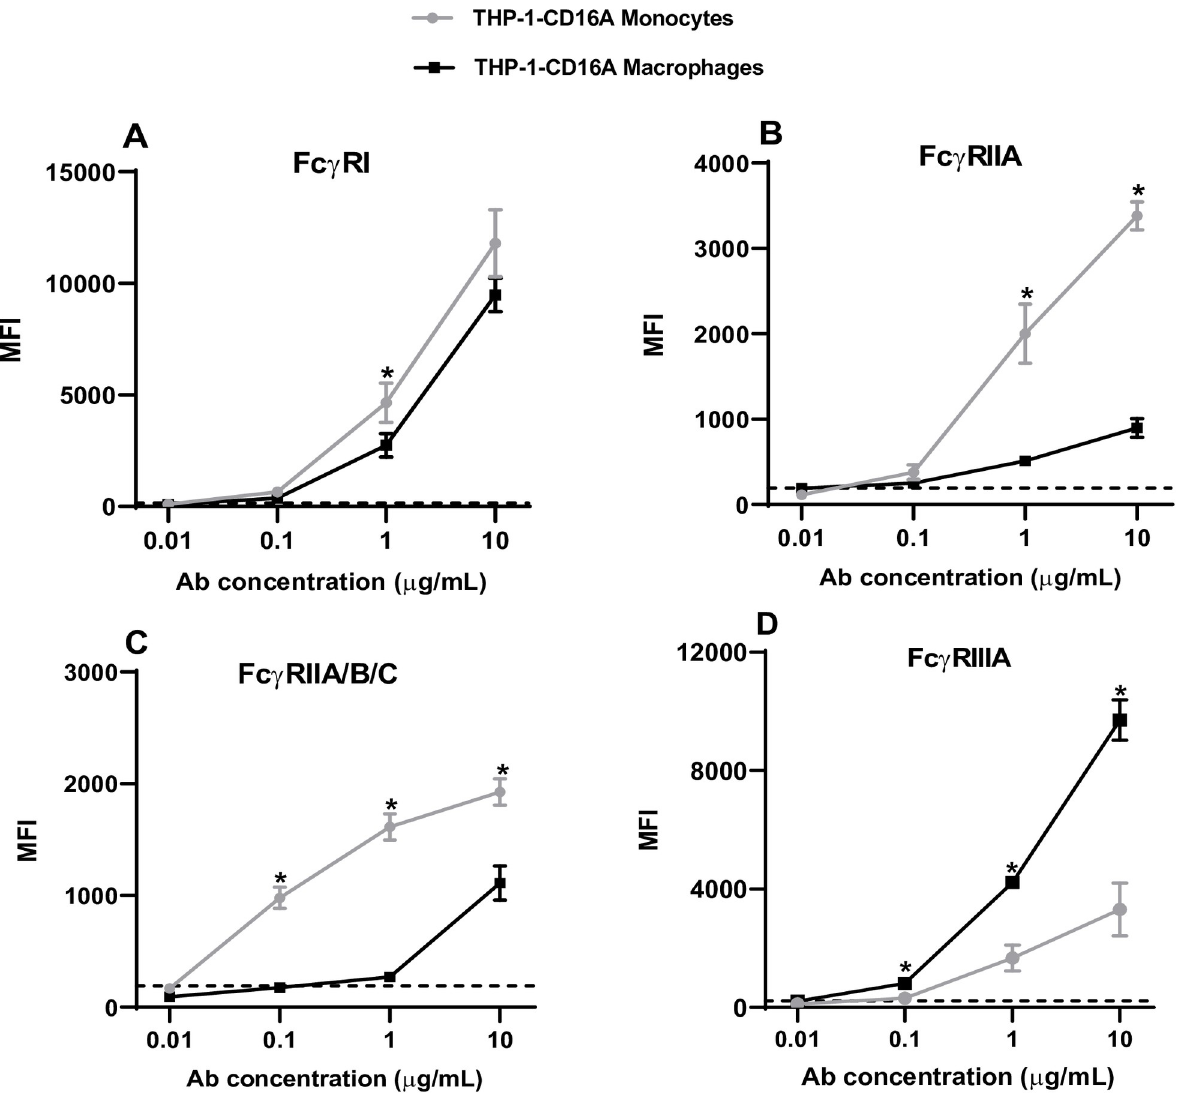
Fig 3. Expression of human Fc γ Rs on non-differentiated and PMA-differentiated THP-1-CD16A cells. THP-1-CD16A cells were differentiated to macrophages by treatment with PMA (100 ng/mL) as described in the Materials and methods. Five hundred thousand cells were stained with direct-labelled monoclonal antibodies against (A) Fc γ RI (clone 10.1 conjugated to PE/Cy7), (B) Fc γ RIIA (clone IV.3 conjugated to FITC), (C) Fc γ RIIA/B/C (clone AT10 conjugated to AF647), or (D) Fc γ RIIIA (clone 3G8 conjugated to BV421). Stained cells were washed and analyzed by flow cytometry using a BD LSRFortessa X-20. Data analysis was performed using FlowJo v10. Data are presented as the mean ± the standard deviation from four independent experiments. MFI: Mean fluorescent intensity (arbitrary units). Ab concentration: Concentration of the fluorescent antibody for Fc γ R expression detection. The dashed line represents the MFI value of the corresponding isotype control at 10 μ g/mL. The statistical analysis was performed by the non-parametric Mann-Whitney T-test, comparing the MFI of both conditions for each antibody concentration ( � : p = 0.05). without any blocking antibody (Fig 5A). However, in THP-1-CD16A cells, roughly 30% of phagocytosis was reduced when they were incubated with a Fc γ RIIIA blocking antibody (Fig 5B), demonstrating the contribution of Fc γ RIIIA in the phagocytosis of anti-D-opsonized human erythrocytes in these cells. Moreover, a very low level of phagocytosis was attained when THP-1-CD16A cells were treated with a combination of all blocking antibodies (Fig 5B), demonstrating that multiple Fc γ Rs were involved in the phagocytosis of the RBC. As expected,